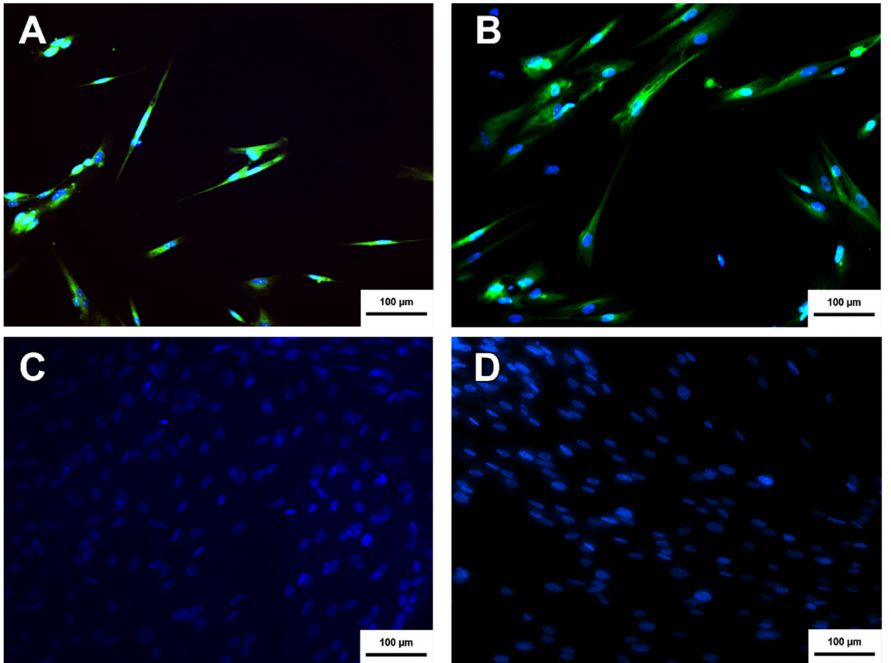
Figure 8. Cholinergic differentiation immunocytochemistry of NPCN+ cells derived from MSC-WJ. ( A ) MSC-WJ labeling using the anti-ChAT antibody (FITC). ( B ) MSC-WJ labeling using the anti-ßIII-TUBULIN antibody (FITC). ( C , D ) represent the negative controls (MSC-WJ not differentiated) for both markers anti-ChAT and anti-ßIII-TUBULIN, respectively Hoechst was used for labeling the nuclei (Image obtained using an inverted fluorescence microscope × 100, Axio Vert A1, Carl Zeiss, Oberkochen, Germany).